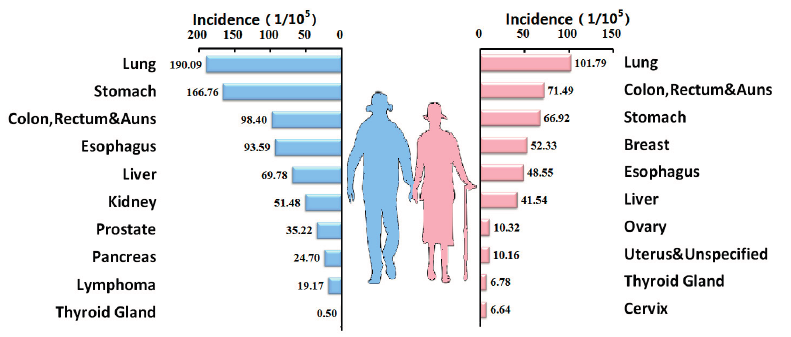
Figure 2. Top ten cancers in the elderly population in China,